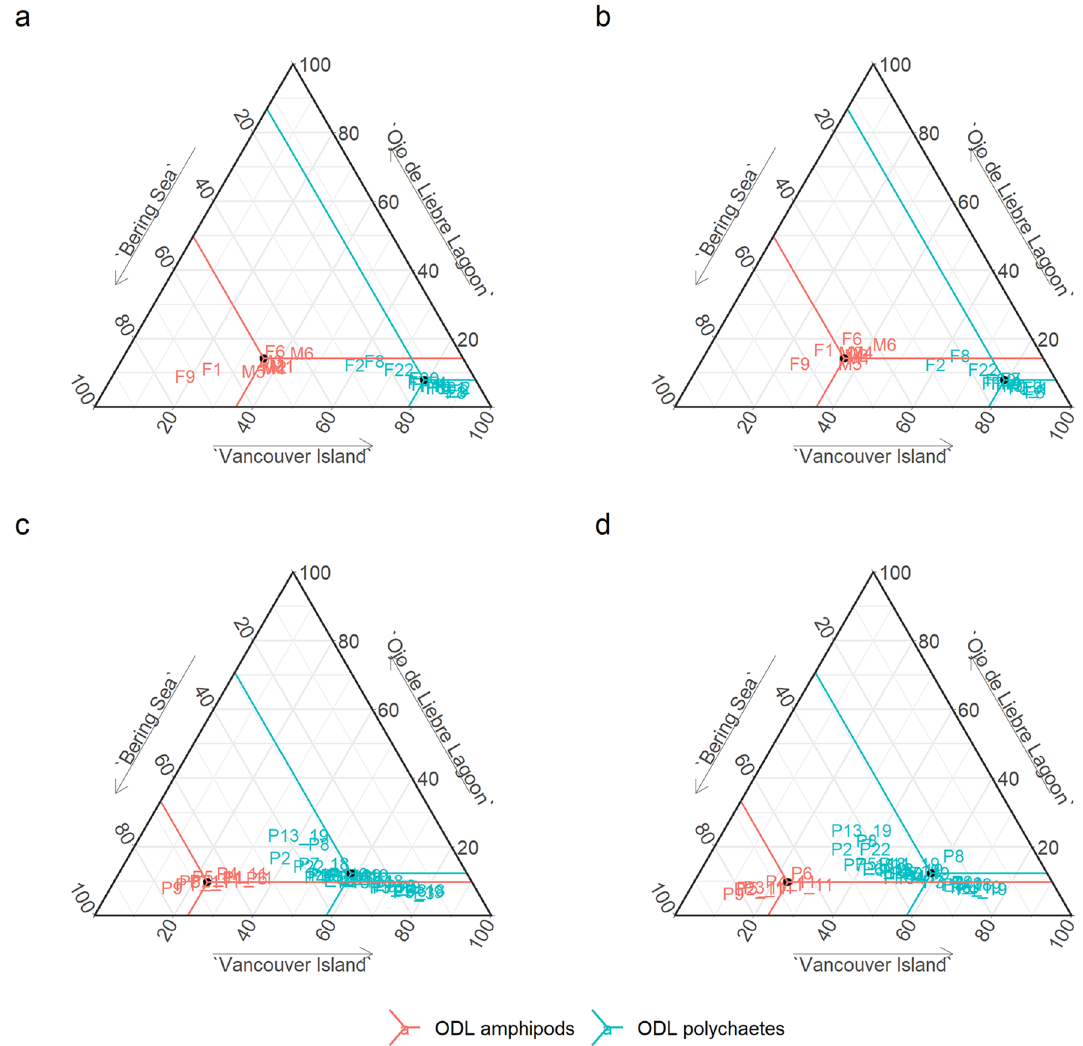
Figure 3. Ternary plots, representing the estimated percentages of contribution of the three considered sources to the isotopic mixture of gray whale tissues. Points coloration pattern shows which source between amphipods (red color) and polychaetes (light-blue color) from the breeding lagoon (ODL = Ojo de Liebre Lagoon) had a higher probability to influence the isotopic mixture of mothers’ SC ( a ), mothers’ SB ( b ), estimated placental blood (i.e., calves’ SC, ( c ) and estimated maternal milk (i.e., calves’ SB, d